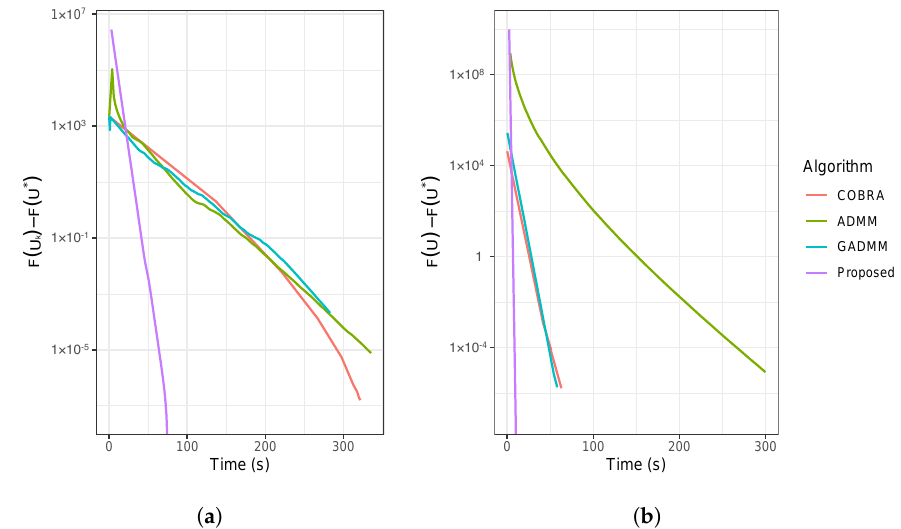
Figure 5. Plot of log ( F ( U k ) − F ( U ∗ )) vs. the elapsed time. ( a ) TCGA; ( b )